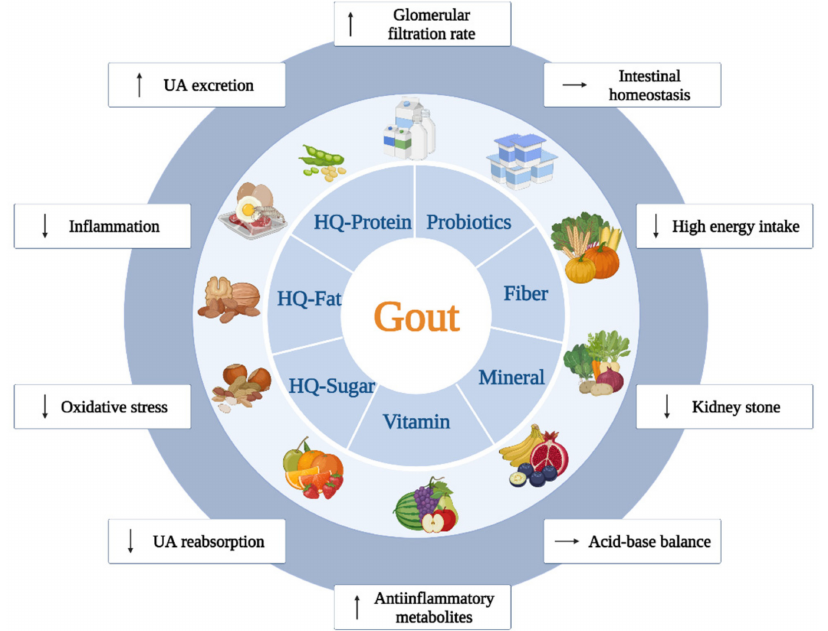
Figure 3. Recommended food-derived nutritional interventions with anti-gouty mechanisms. Dietary management recommendations for gout patients include appropriate intake of fiber, minerals, and vitamins, as well as the selection of high-quality sugars, fats, and proteins, which are usually of plant origin. In addition, the consumption of products containing probiotics helps regulate intestinal homeostasis in patients with gout. ↑ —increase; ↓ —decrease; → —maintain; UA—uric acid; HQ—